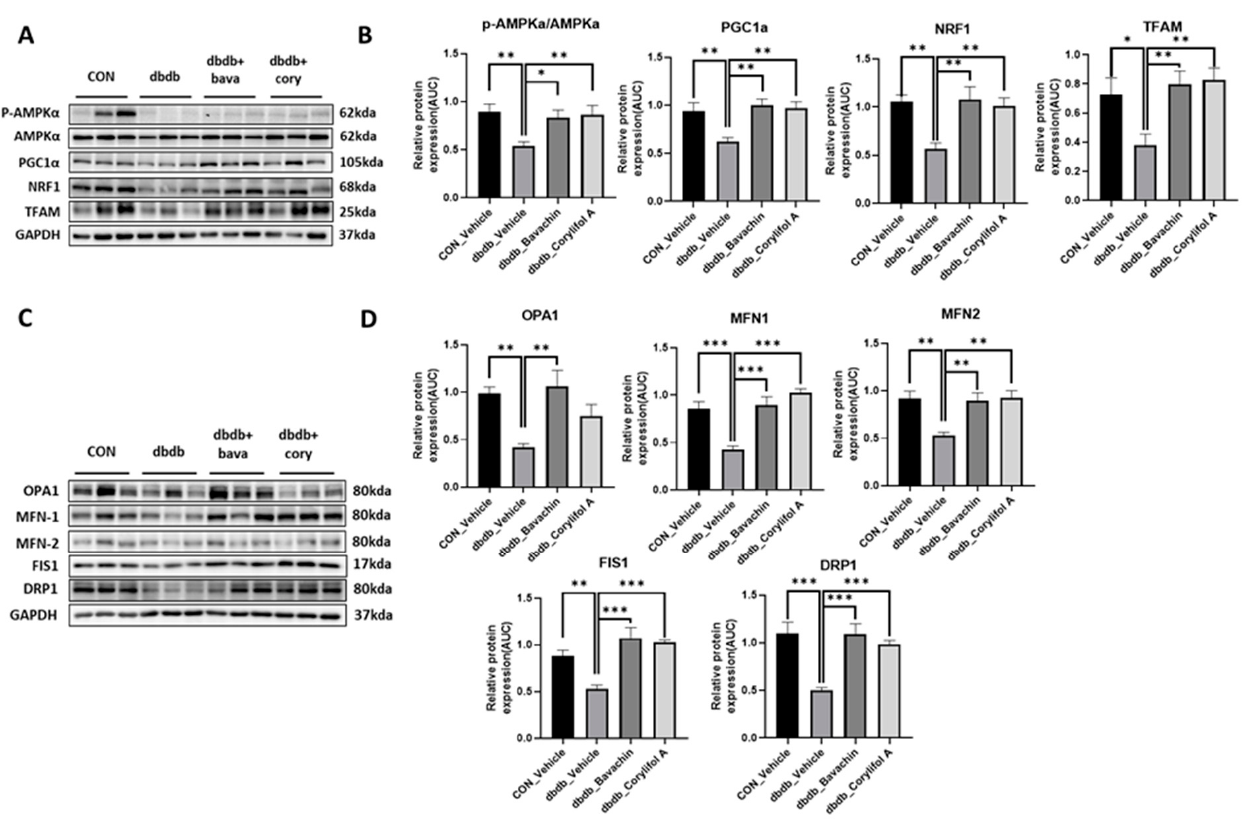
Figure 7. Bavachin and corylifol A induce mitochondrial dynamics in the skeletal muscle via the AMP-activated protein kinase (AMPK) signaling pathway. Twelve week old male db/db mice were administered bavachin (10 mg/kg) or corylifol A (10 mg/kg) for 40 d. Protein expression levels in the GA muscle were measured via western blotting. ( A ) Representative images of mitochondrial biogenesis. ( B ) Protein expression levels of mitochondrial biogenesis. ( C ) Representative images of fusion and fission factors. ( D ) Protein expression levels of fusion and fission factors. All data are represented as the mean ± S.E.M., n = 6/group; * p < 0.05, ** p < 0.01, *** p < 0.001; nonparametric analysis of variance, followed by Kruskal-Wallis